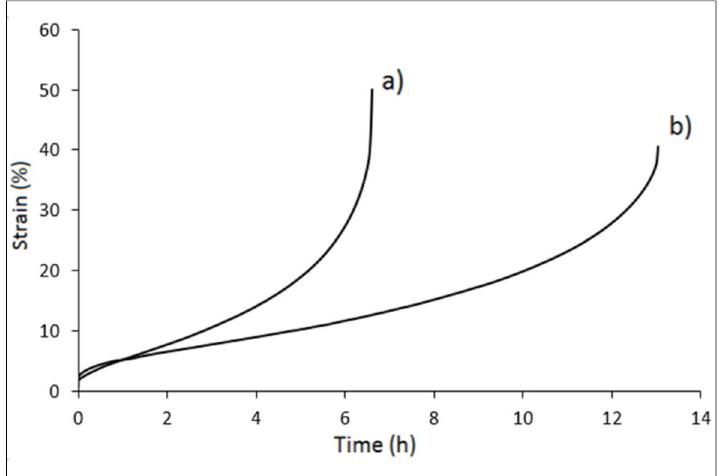
Figure 17. Strain–time curves for specimen A (test temperature and load respectively equal to 600 °C and MPa): ( a ) As-built specimen; ( b ) Smoothed specimen.